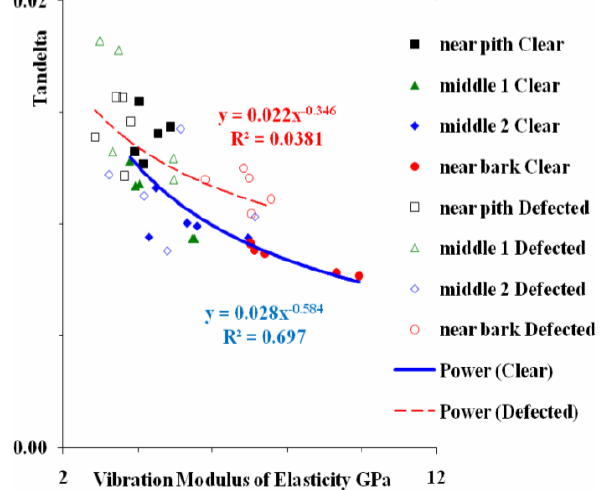
Fig. 6. Static modulus of elasticity and damping in knot-contain- ing and knot-free specimens from pith to bark